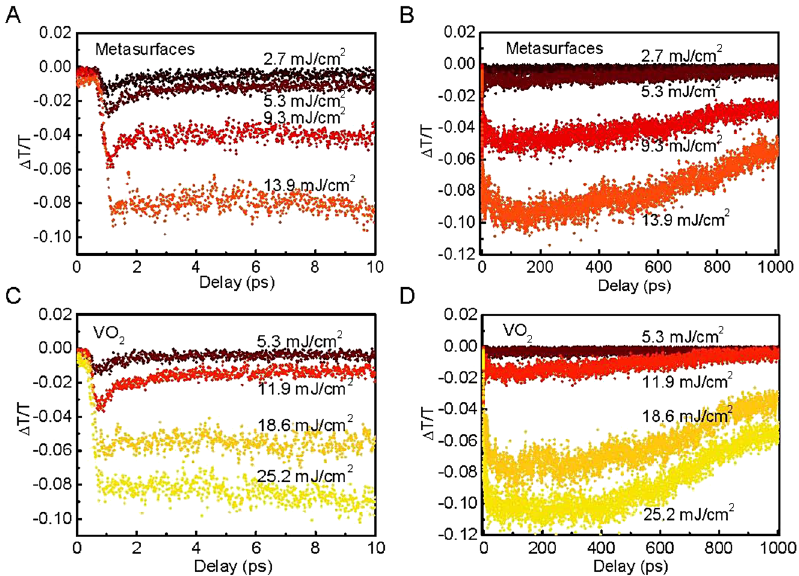
Figure 4: Ultrafast spectral response of the fabricated